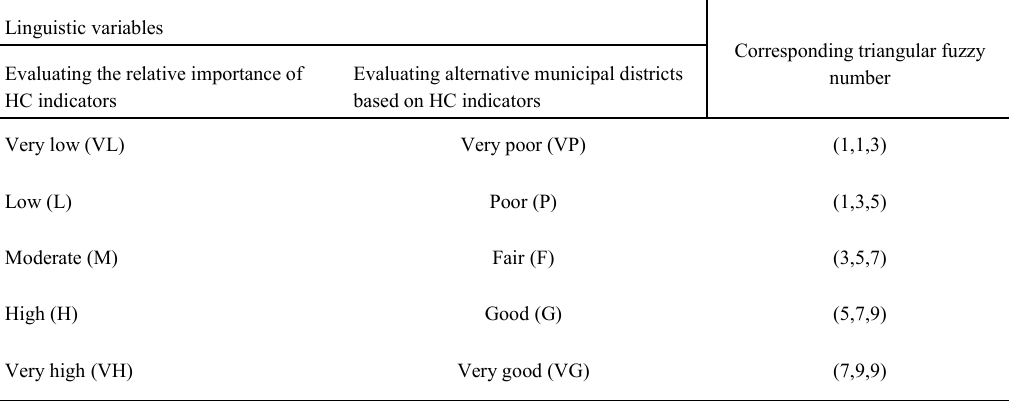
Table 2: Linguistic variables and their respected fuzzy numbers (Wang and Wu, 2016)